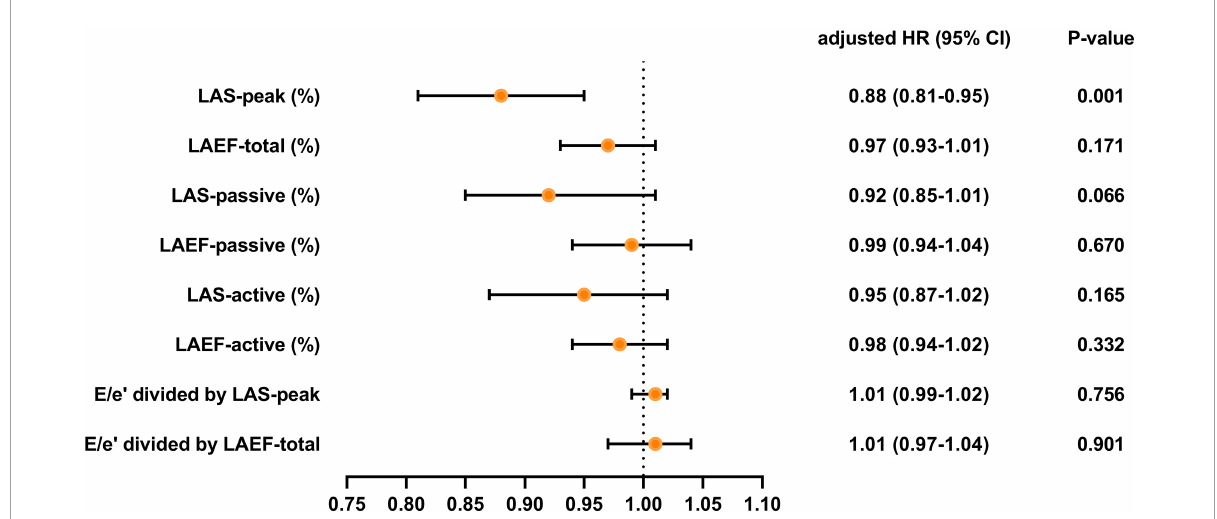
FIGURE4 Adjusted HR for various measures of LA function and stiffness HR, hazard ratio; LA, left atrial; LAS, LA strain; LAEF, LA ejection fraction. Models were adjusted for BMI, diabetes, LV global longitudinal strain, LA volume index, and (or) E/e’.